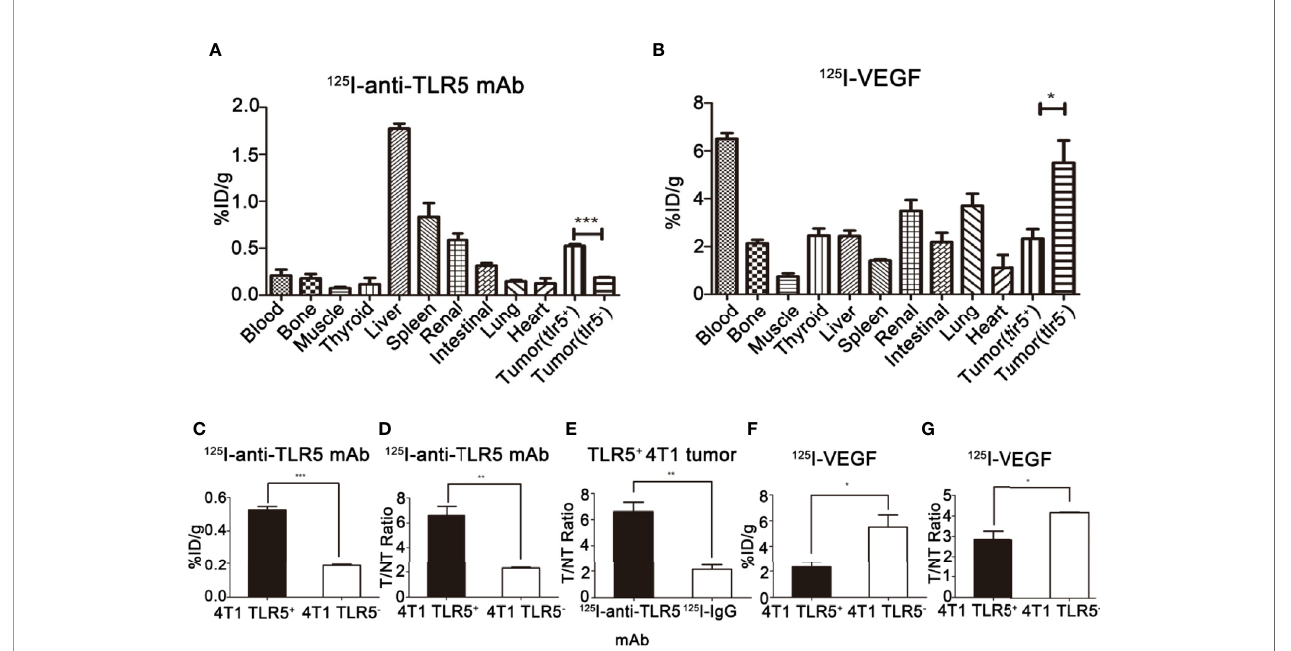
FIGURE 5 | Ex vivo biodistribution studies of 125 I-anti-TLR5 mAb and 125 I-VEGF. Biodistribution of 125 I-anti-TLR5 mAb at 48 h post-injection in different organ or tissues (A) . Biodistribution of 125 I-VEGF at 24 h post-injection in different organs or tissues (B) . Comparison about the tumor uptake of 125 I-anti-TLR5 mAb in 4T1 TLR5 + and 4T1 TLR5 − tumor bearing mice (C) . Comparison about T/NT in TLR5 + / − 4T1 bearing mice injected with 125 I-anti-TLR5 mAb at 48 h (D) . Comparison of tumor uptake in TLR5 + 4T1 bearing mice injected with 125 I-anti-TLR5 mAb and 125 I-IgG at 48 h (E) . Comparison about the tumor uptake of 125 I-VEGF in 4T1 TLR5 + and 4T1 TLR5 − tumor bearing mice (F) . Comparison about T/NT in TLR5 + / − 4T1 bearing mice injected with 125 I-VEGF at 24h (G) . The data were presented from three independent experiments and analyzed by Student ’ s t test. *P < 0.05, **P < 0.01, ***P <